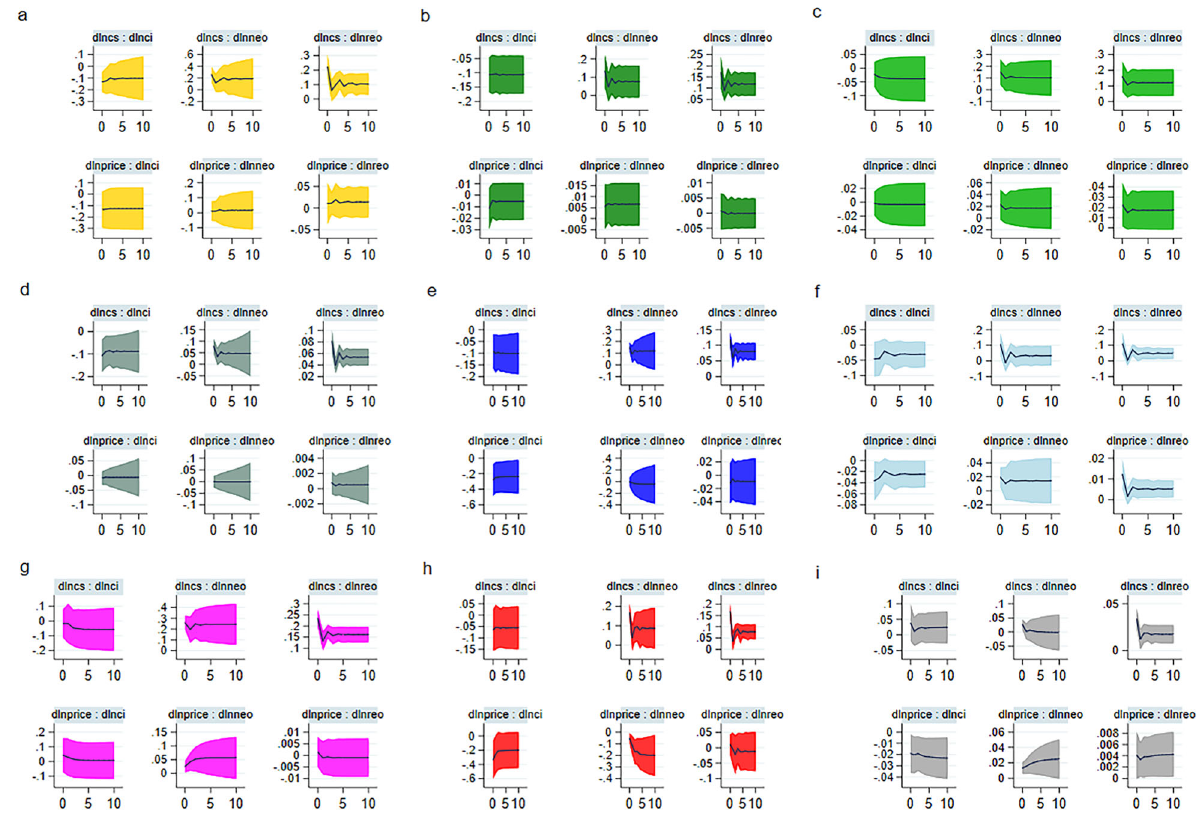
Fig. 6 Dynamic multipliers of CO 2 absorbed through net primary production and carbon shadow price in 9 groups. a The dynamic multipliers of CO 2 absorbed through net primary production and carbon shadow price in countries with high neo and reo. b The dynamic multipliers of CO 2 absorbed through net primary production and carbon shadow price in countries with high neo and middle reo. c The dynamic multipliers of CO 2 absorbed through net primary production and carbon shadow price in countries with high neo and low reo. d The dynamic multipliers of CO 2 absorbed through net primary production and carbon shadow price in countries with middle neo and high reo. e The dynamic multipliers of CO 2 absorbed through net primary production and carbon shadow price in countries with middle neo and reo. f The dynamic multipliers of CO 2 absorbed through net primary production and carbon shadow price in countries with middle neo and low reo. g The dynamic multipliers of CO 2 absorbed through net primary production and carbon shadow price in countries with low neo and high reo. h The dynamic multipliers of CO 2 absorbed through net primary production and carbon shadow price in countries with low neo and middle reo. i The dynamic multipliers of CO 2 absorbed through net primary production and carbon shadow price in countries with low neo and fi gshare.19561624.v1). The results imply that raising CO 2 abatement policy stringency (or carbon shadow price) may only statistically contributed to country with low reo (e.g., Malaysia